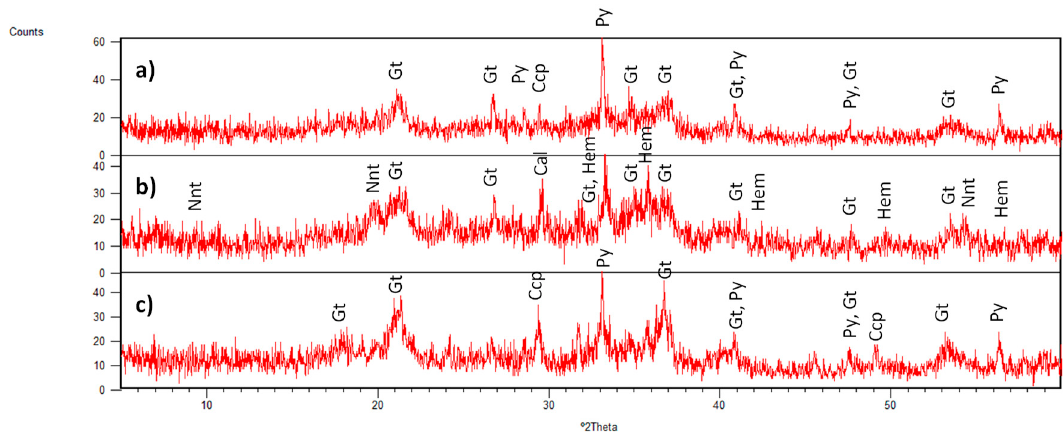
Figure 6. XRD patterns of sediment samples selected from GC-627: ( a ) C-118, ( b ) B-175 and ( c ) A-226. (For mineral name abbreviations and d-spacing labeled as a plane direction of h k l , see Table